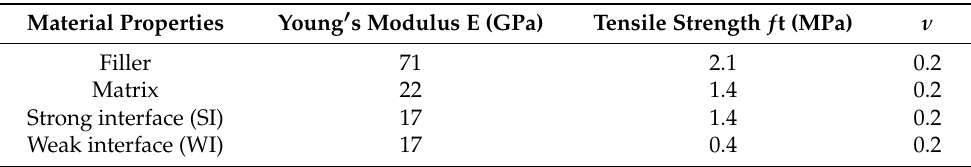
Table 1. Mechanical properties of materials and